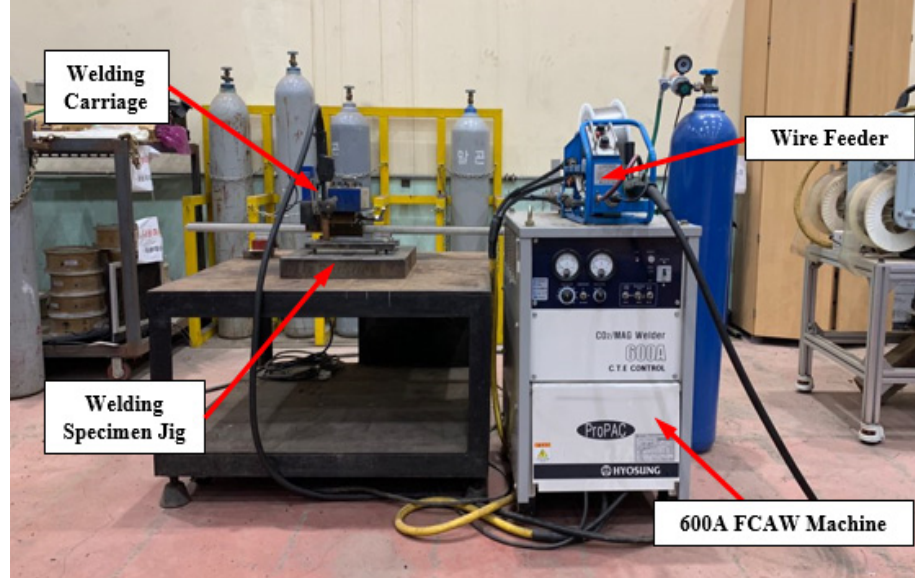
Figure 1. Experimental setup for flux cored arc welding [7].